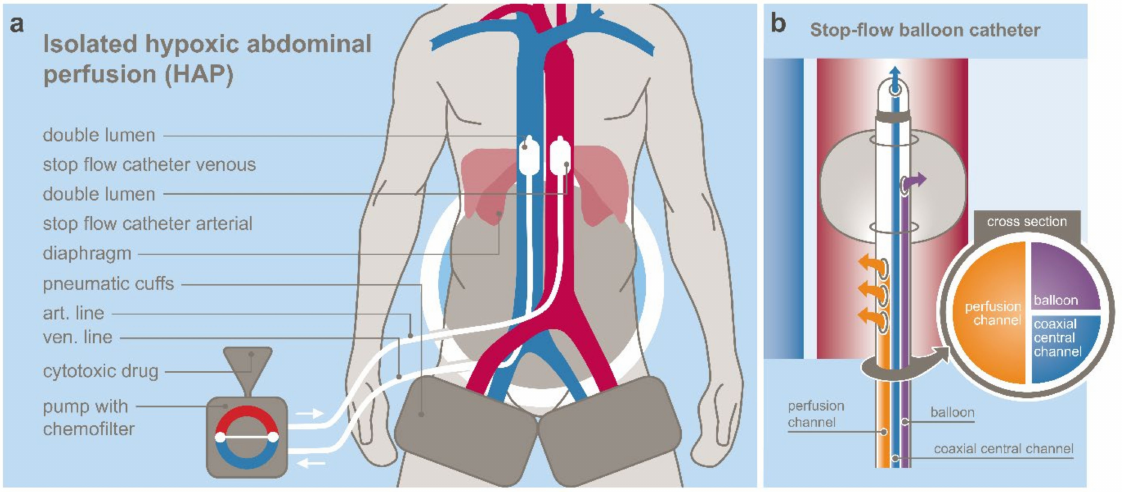
Figure 1. ( a ) schematic principle of hypoxic abdominal perfusion; ( b ) stop-flow catheter